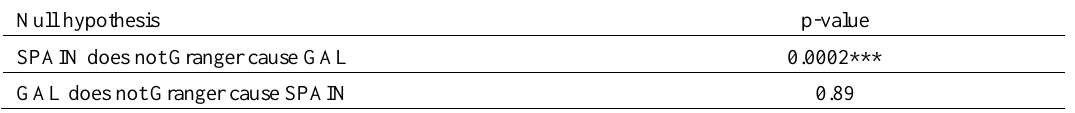
Table 2 : Granger causality test. Period 1996Q1 −